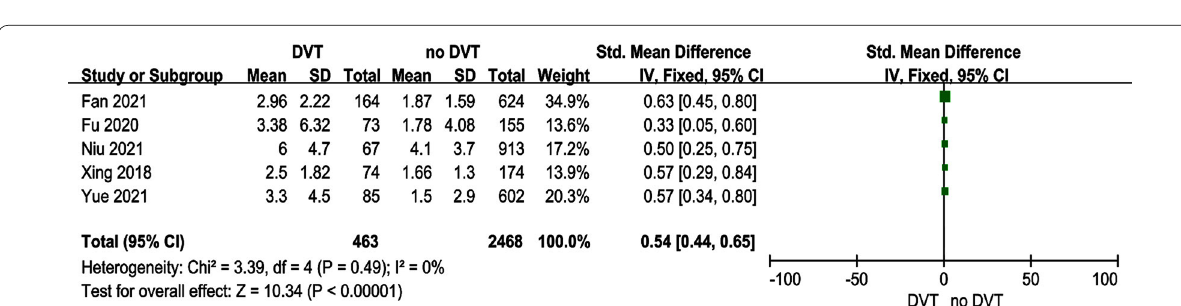
Fig. 7 Forest plot showing time from injury to admission in 2 groups. CI confidence interval, df degrees of freedom, M-H Mantel–Haenszel